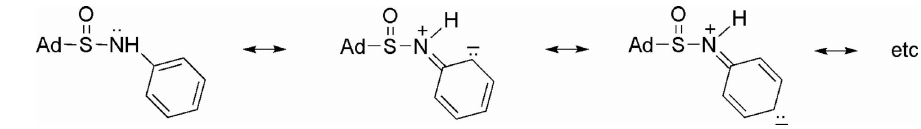
Figure 2 Resonance structures for